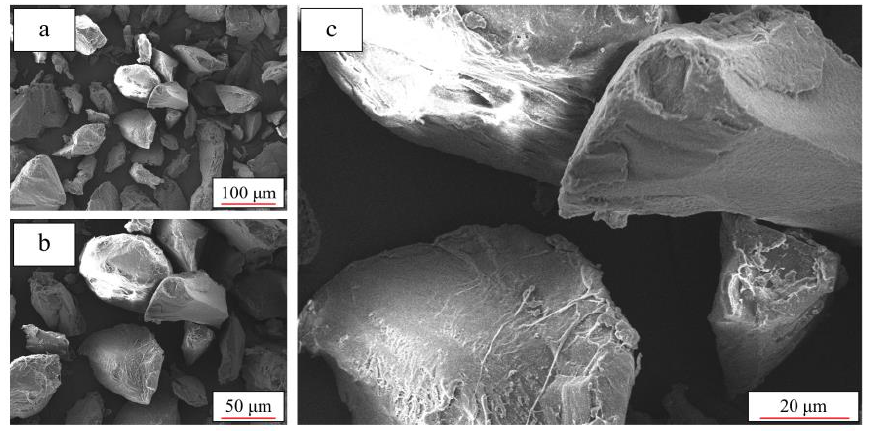
Figure 16. Microstructure of new TPU powder under different magnifications: ( a ) 500×; ( b ) 1000× and ( c ) 2000×.